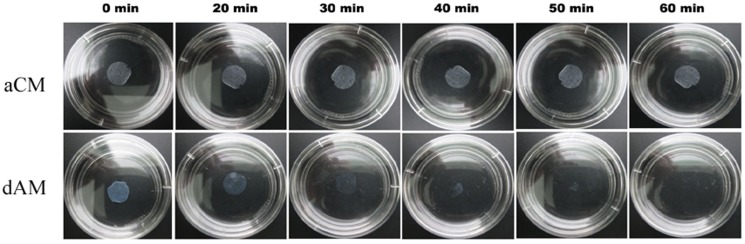
Morphological changes in acellular conjunctiva matrix and denuded amniotic membrane after 0.25% collagenase digestion.